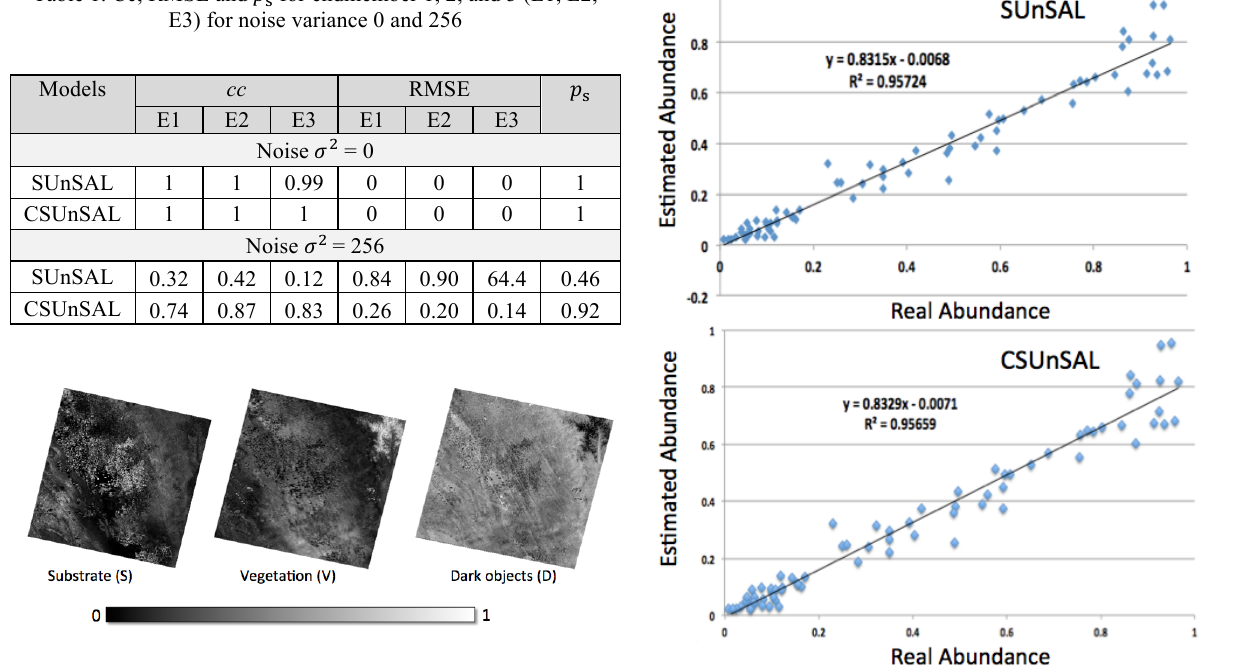
Figure 4. Abundance maps obtained from CSUnSAL for SVD classes. In the legend, 0 (black) indicates absence of a particular class and 1 (white) indicates full presence of that class in a pixel. Intermediate values of the shades of gray represent mixture of more than one class in a pixel.